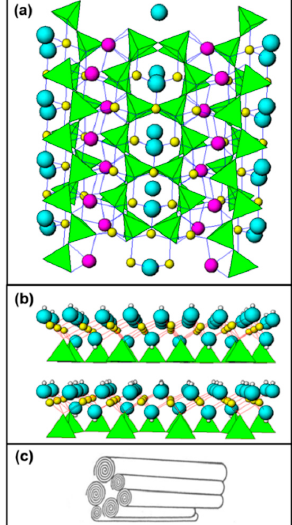
Figure 1. ( a ) Crystal structure of amphibole minerals: in green the [SiO 4 ] tetrahedra, in blue the (OH) - groups, in yellow and in violet the Na, Ca, Mg, Fe 2+ , or Fe 3+ cations; ( b ) Crystal structure of serpentine minerals: in green the [SiO 4 ] tetrahedra (T layers), in yellow the octahedral Mg cations (O layer), and in blue and white the OH - groups; ( c ) In chrysotile T and O layers roll up around a hole forming long fibers.